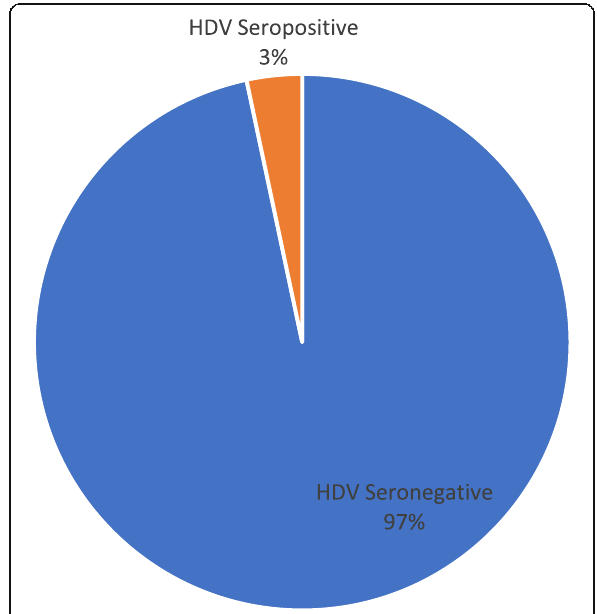
Fig. 1 Prevalence of anti-HDV among HBsAg-seropositive study